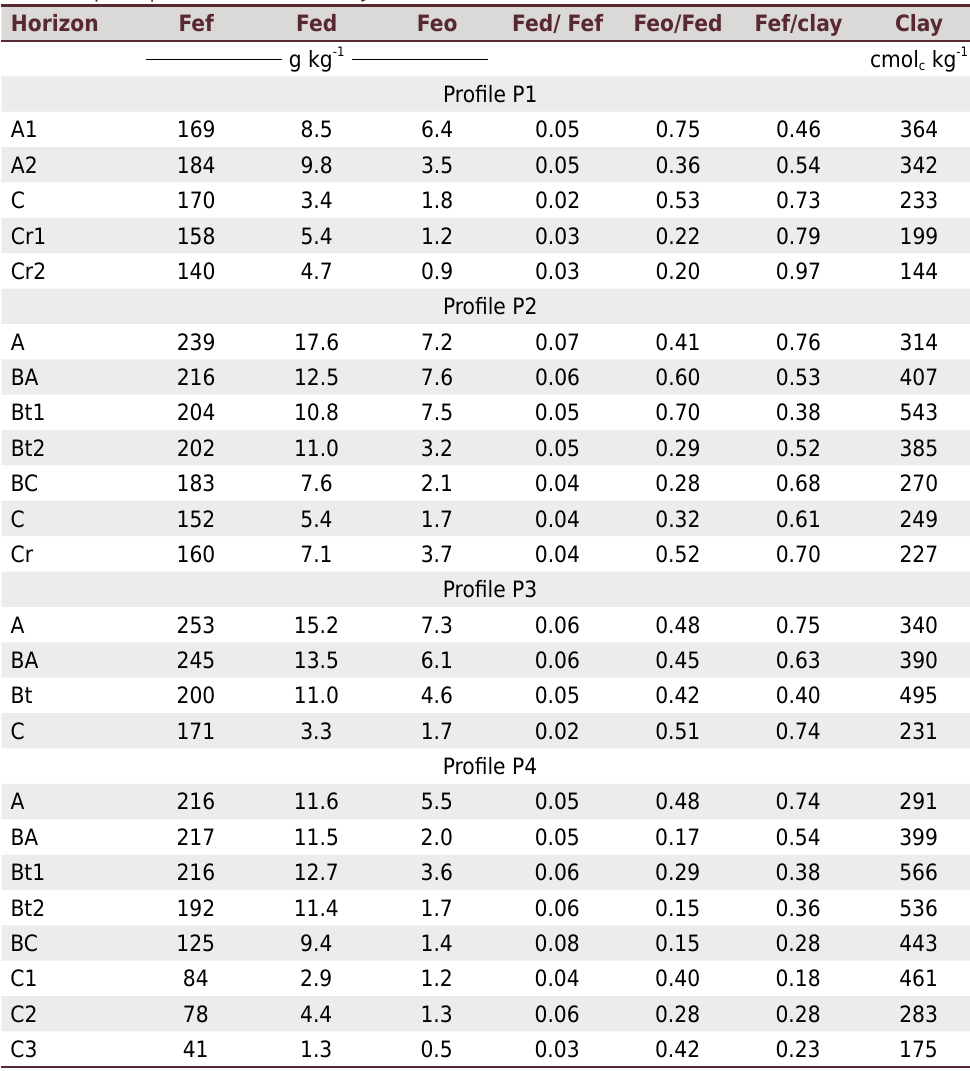
Table 6. Iron levels determined by X ray fluorescence (Fef), extracted with dithionite citrate bicarbonate (Fed) and acid ammonium oxalate (Feo) and their relationship with clay in soil horizons from a toposequence in Pinheiral,